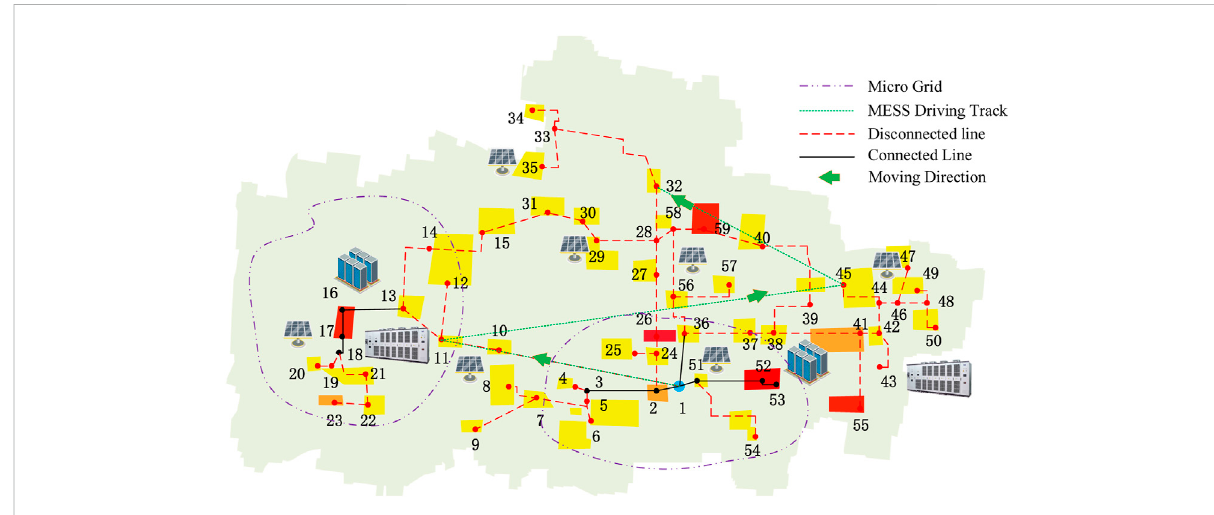
FIGURE 14 Island partition and MESS allocation result of RO90.